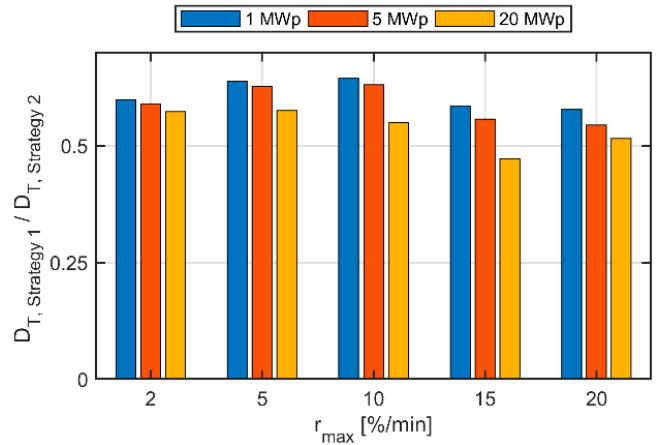
Figure 11. Total degradation ratio between Strategy 1 and 2, assuming that Strategy 1 works with the C bat required by Strategy 2. Table 3. Degradation comparison for different models.